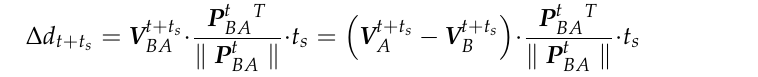
Figure 5. Schematic of minimum distance prediction for dual manipulators system within the sampling period ( t ∼ t + t s ). O 1 O 2 and O 3 O 4 denote the minimum distance links for manipulator A and B, and P t and P t are the closest points on the two minimum distance links, respectively. V t + t s Ac and V t + t s B are the displacement velocity vectors of and at the current moment . Here, we simplify the non-linear movement of the minimum distance point along the link to a linear advection, so that ∆ d t + t s can be easily approximated using dynamic spatial geometry.